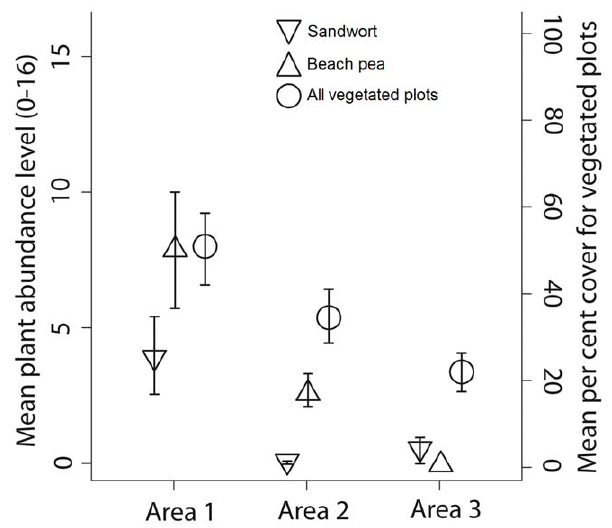
Figure 4. Comparison of the mean abundance of sandwort Honckenya peploides (right-side-up triangle) and beach pea Lathyrusjaponicas (upside-down triangle) with percent cover for vegetated plots (open circle) in areas 1, 2, and 3 (west to east) on Sable Island, Canada, 2010. Error bars are ± 1 SE.